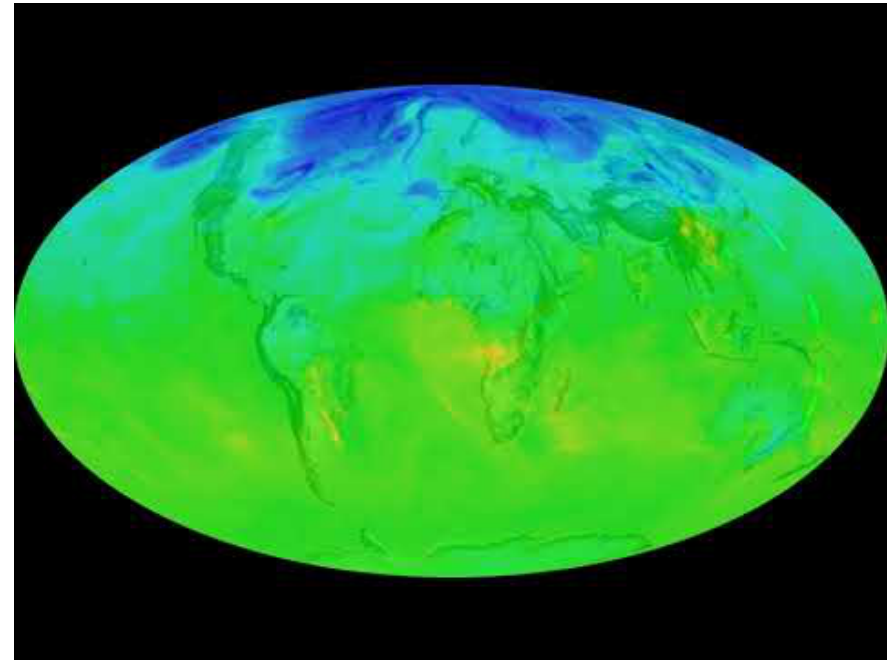
Figure 4: Clip from climate model visualization Assimilation of OCO-2 Carbon Dioxide into the GEOS Simulation (2016). The trace of the satellite data is visible not just where the satellite data is explicitly indicated, but also in faint vertical striping across the width of the